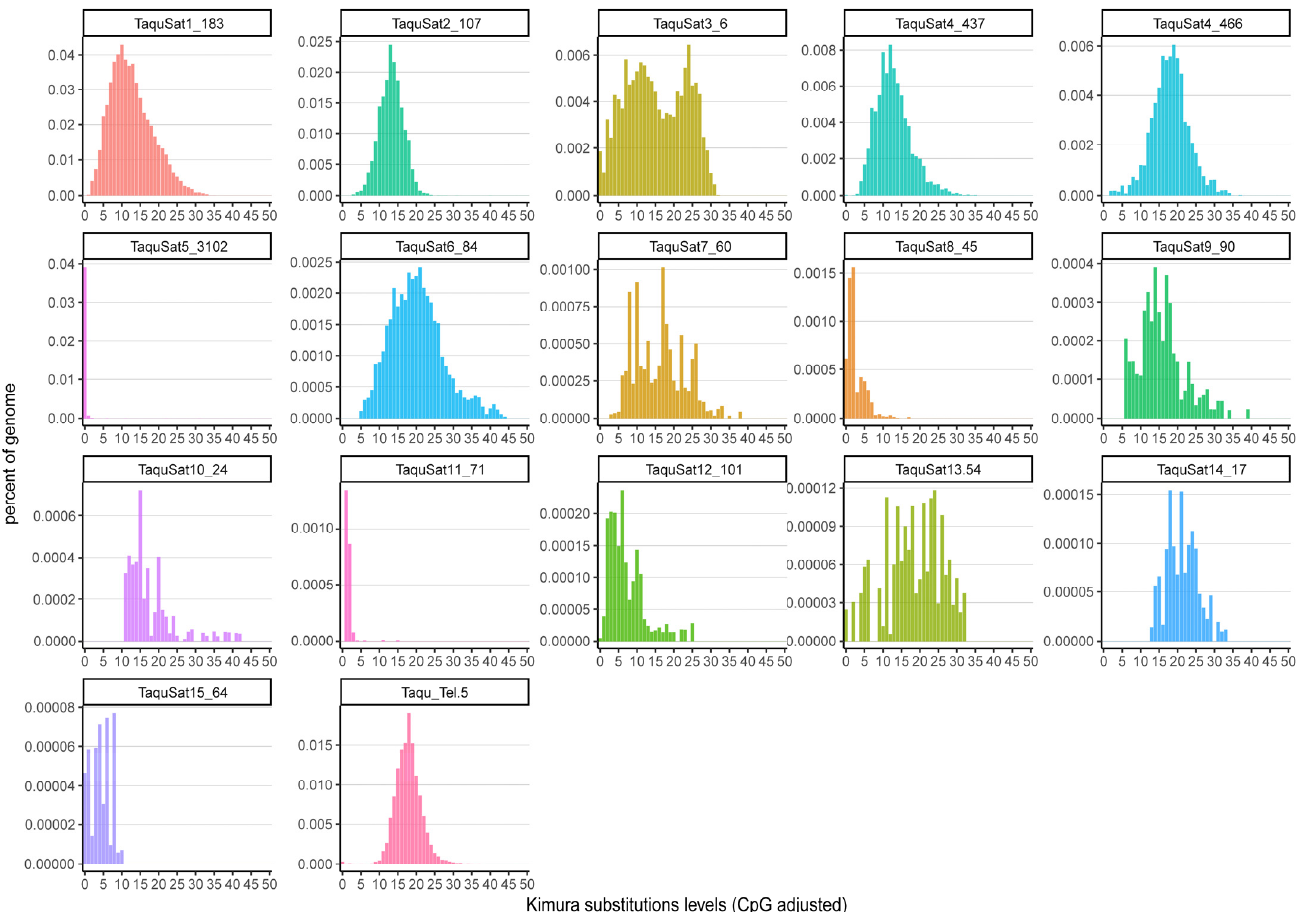
Figure 1. Satellite landscapes (abundance versus divergence) of T. aquitania satDNA families.